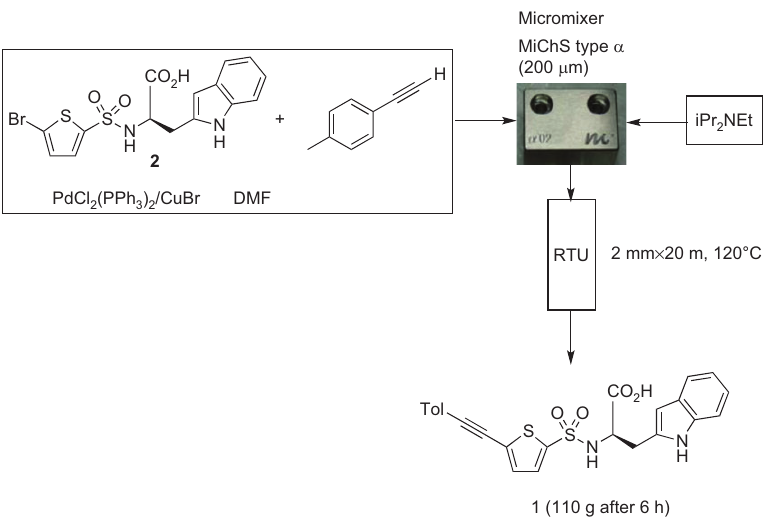
Scheme 10 Continuous-flow synthesis of MMP inhibitor using conventional Sonogashira